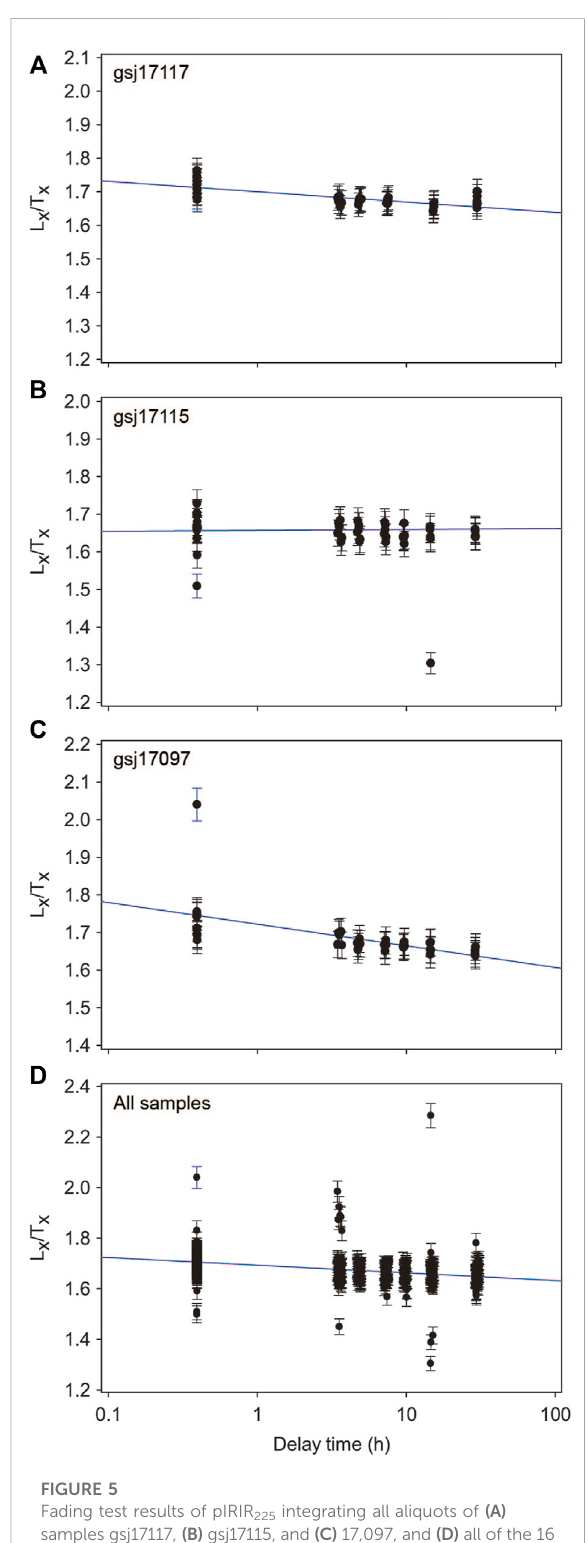
FIGURE 5 Fading test results of pIRIR 225 integrating all aliquots of (A) samples gsj17117, (B) gsj17115, and (C) 17,097, and (D) all of the 16 samples measured here. The result on gsj17117 exempli fi es a fading rate close to the average of all samples, while the fading rates of samples gsj17115 and 17,097 are the lowest and highest values of the 16 samples,